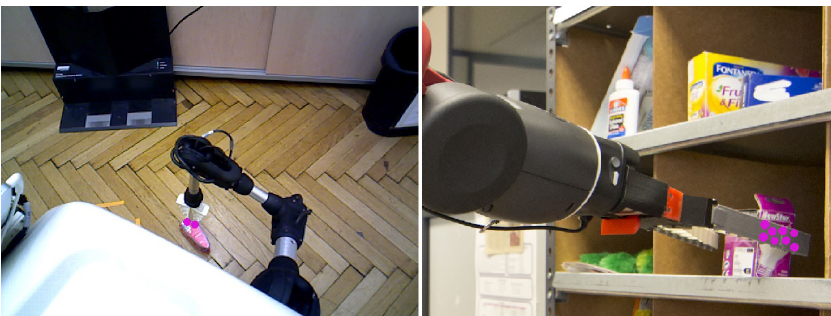
Figure 4. Tricky RGB situations of non-grasping contact points where a visual aligment between an object and the robotic manipulator can be confusing.